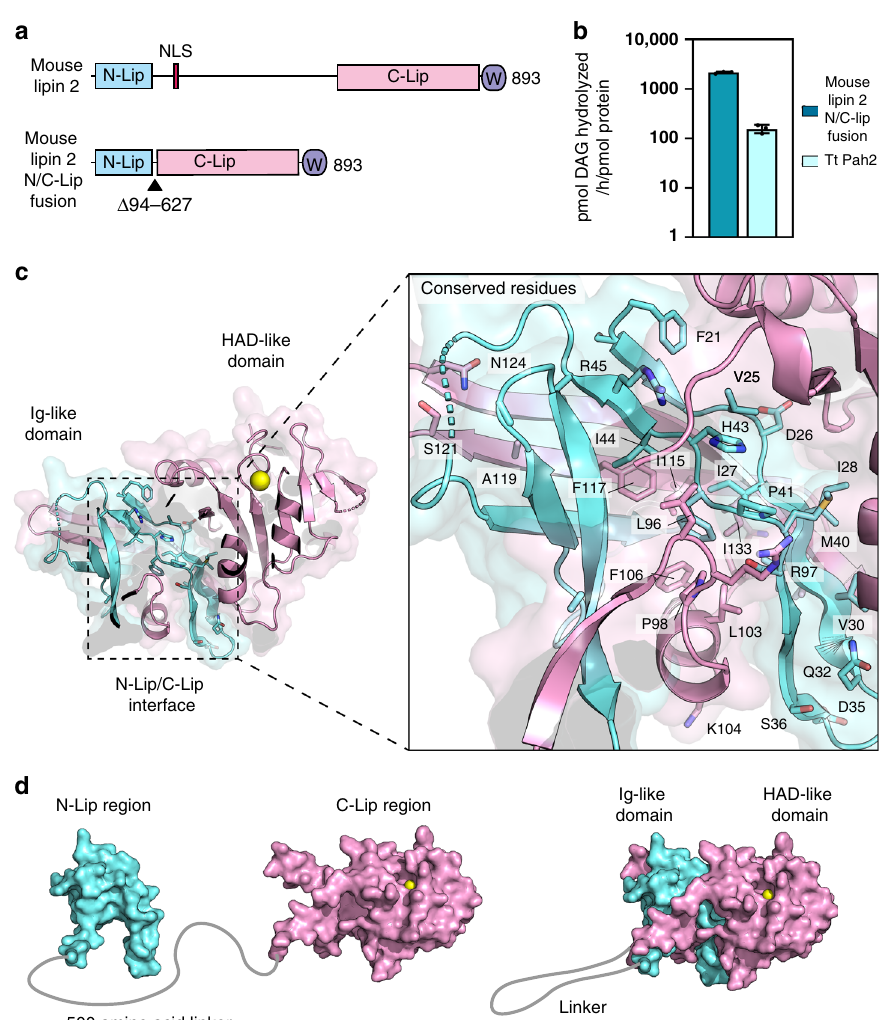
Fig. 6 The N-Lip and C-Lip regions are the functional catalytic unit of lipin/Pah PAPs. a Domain architecture of full-length mouse lipin 2 and an N-Lip C- Lip fusion (residues 94 − 627 deleted) with an analogous architecture to Tt Pah2. The positions of the nuclear localization signal (NLS, red) and conserved Trp-motif (W, purple) are shown. b Mouse lipin 2N/C-Lip fusion is catalytically active and one order of magnitude greater than Tt Pah2. Error bars represent standard deviation ( n = 3) of experiments performed in technical duplicates. c Detailed view of homologous residues at the N-Lip and C-Lip interface. Highlighted residues are shown as sticks and share sequence identify or sequence similarity between Tt Pah2, Sc Pah1, and lipins 1, 2, and 3. d Proposed structure of full-length lipins. The lipin Ig-like domain is a “ split ” domain divided by a ~500 amino acid linker that separates the N-Lip and C-Lip. The two regions must recombine to form a functional PAP enzyme. Source data are provided as a Source Data fi